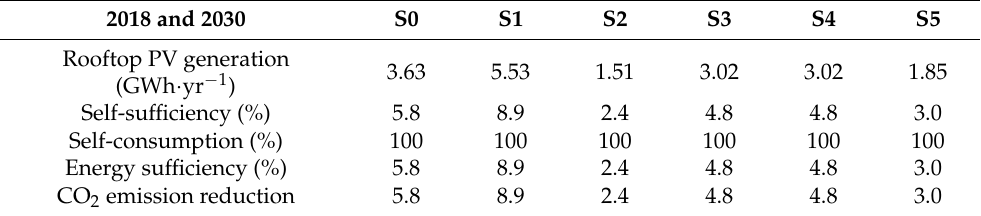
Table 6. Energy indicators for 2018 and 2030. Results are the same for both years as optimal PV capacities are the same for both years. 70% of the rooftop area is used for the maximum PV